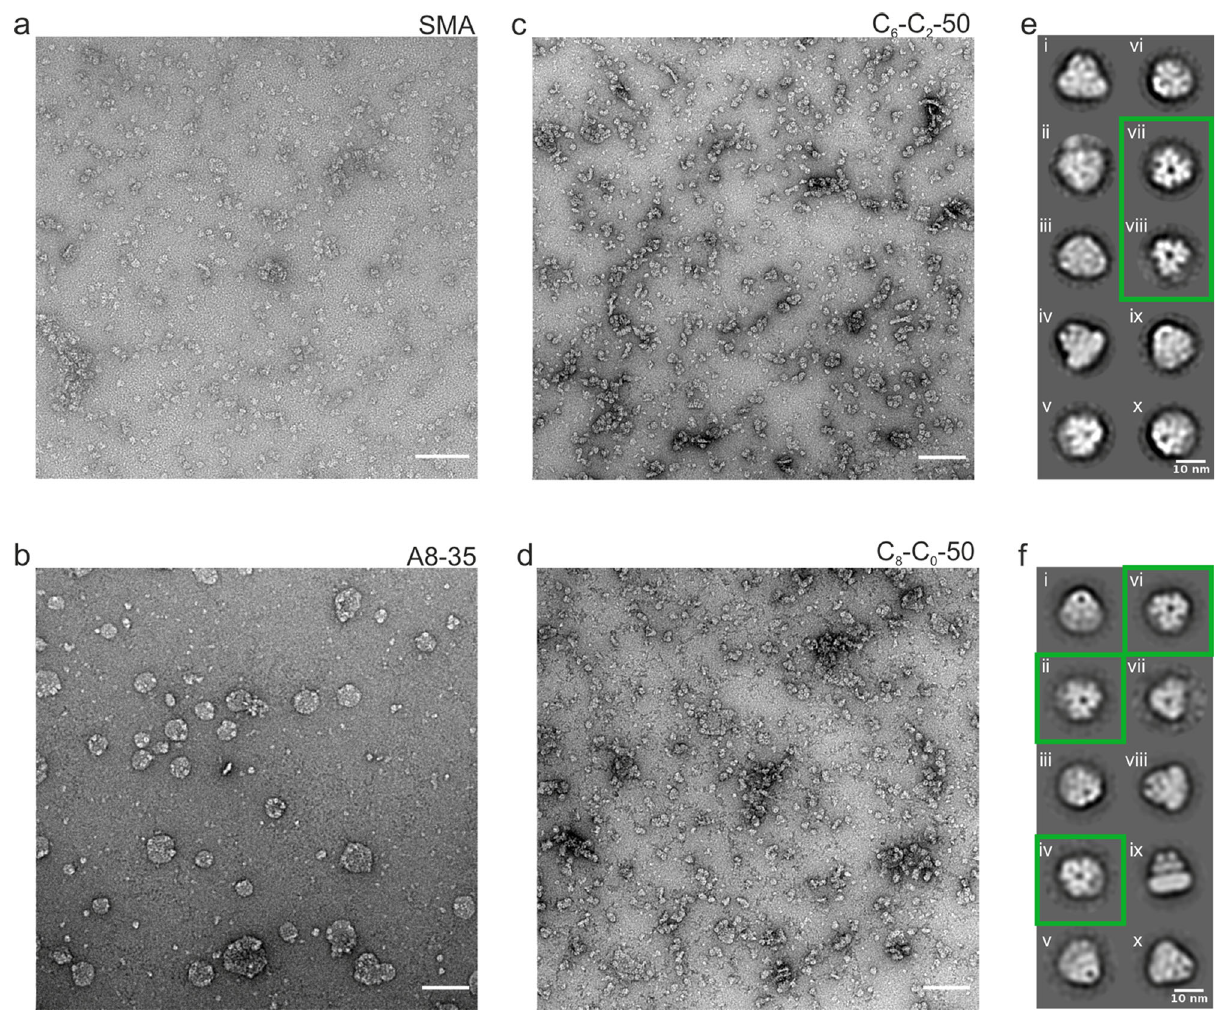
Fig. 2 Negative stain electron microscopy of AcrB extracted and puri fi ed in SMA, A8-35 and CyclAPols. Representative micrographs were collected at 49k magni fi cation of AcrB following puri fi cation in ( a ) SMA, ( b ) A8-35, ( c ) C 6 -C 2 -50, and ( d ) C 8 -C 0 -50. Scale bar is 100 nm in all images. Negative stain 2D classes of AcrB in ( e ) C 6 -C 2 -50 and ( f ) C 8 -C 0 -50 are also shown with some representative high-angle classes highlighted in green. Images ( a) and ( b - d) were taken using Tecnai F20 and G2-spirit T12 transmission electron microscopes,